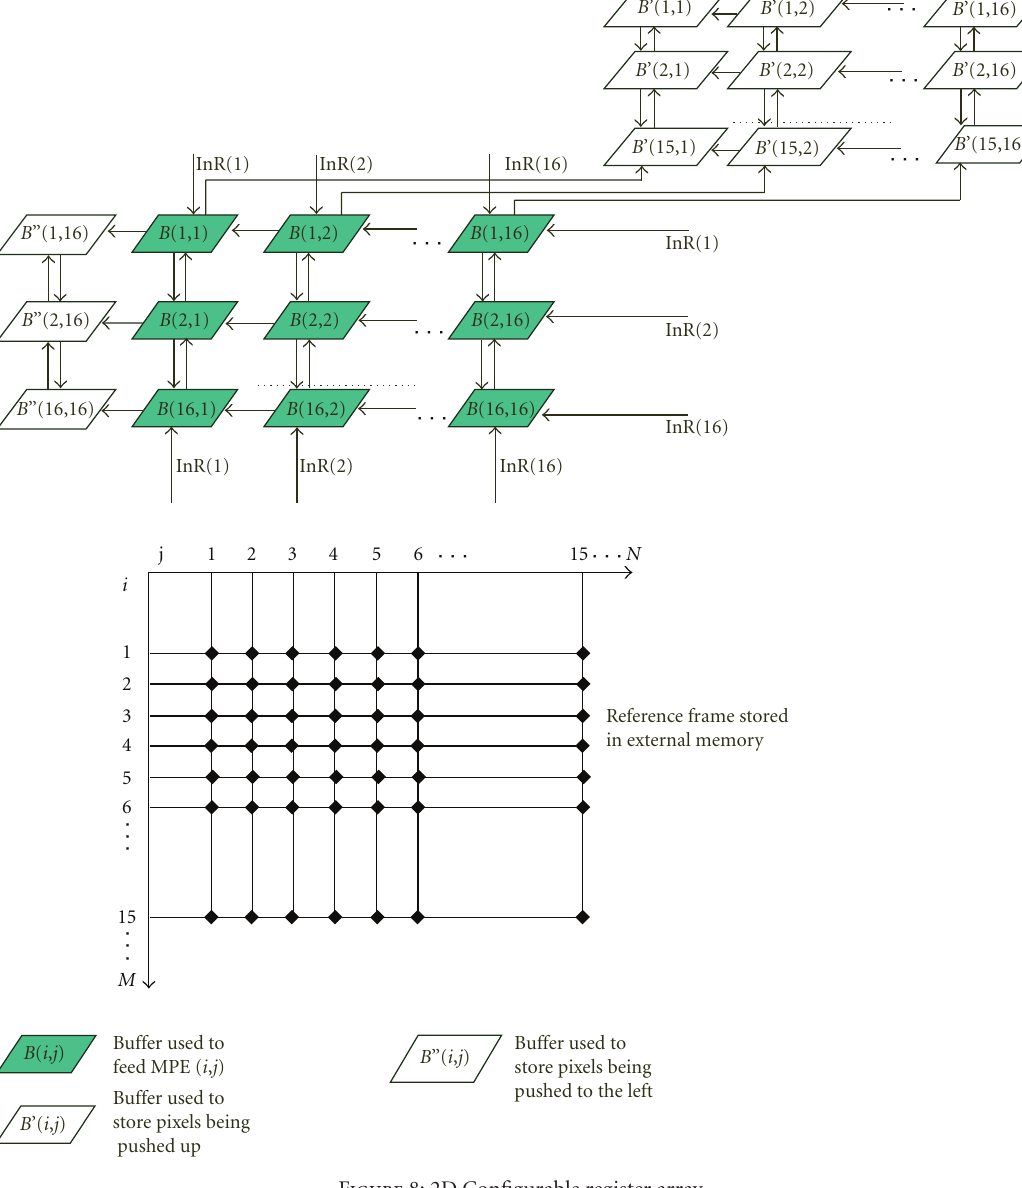
Figure 8: 2D Configurable register